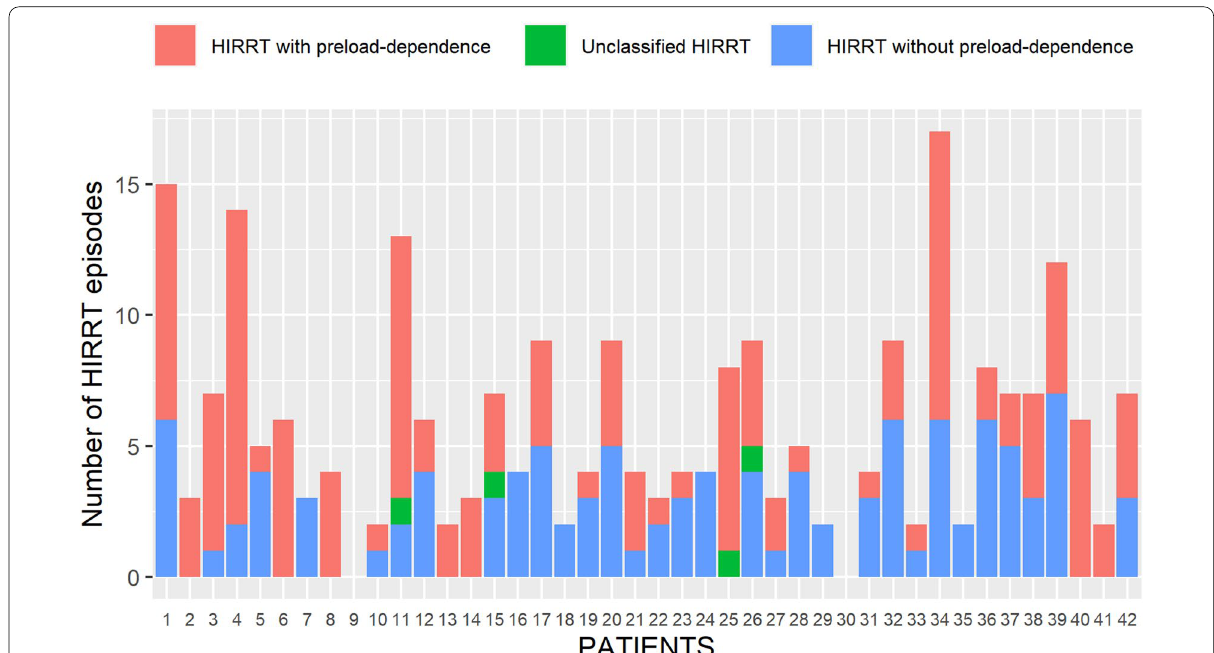
Fig. 2 HIRRT episodes as a function of preload‑dependence status per patient. HIRRT hemodynamic instability related to renal replacement